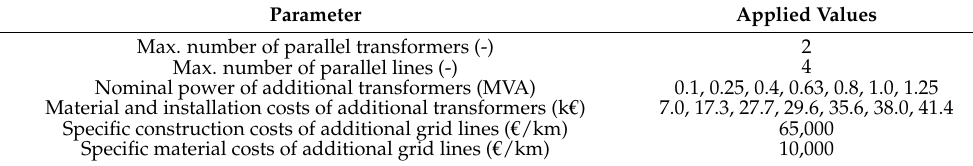
Table 3. Parameters applied for determining required grid reinforcement costs